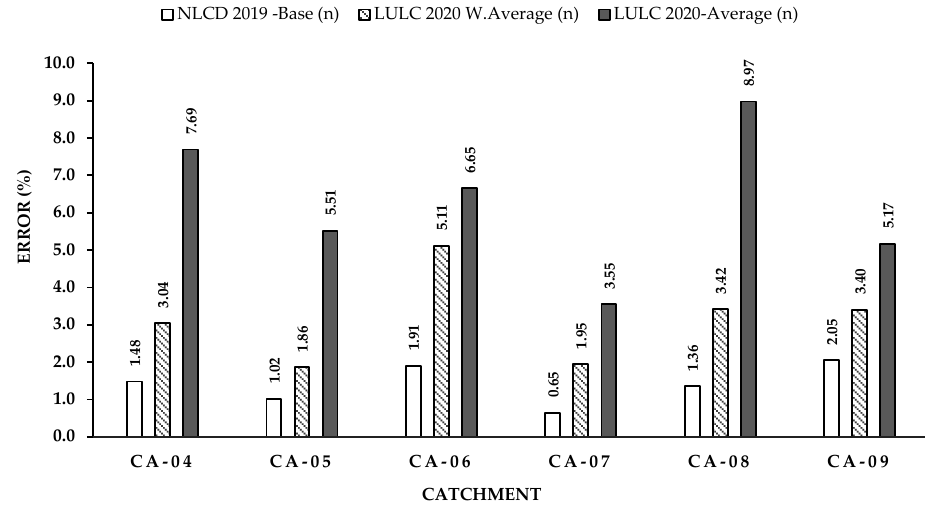
Figure 13. Peak-flow error using LULC 2020-ESRI along with ( n avg ) and ( n w.avg ) values compared to the base validation results.